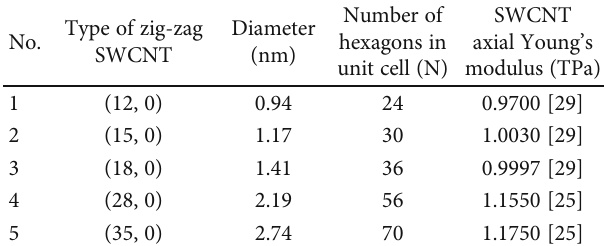
Table 7: Diameter, number of hexagons in unit cell, and axial Young ’ s modulus of zig-zag SWCNTs.